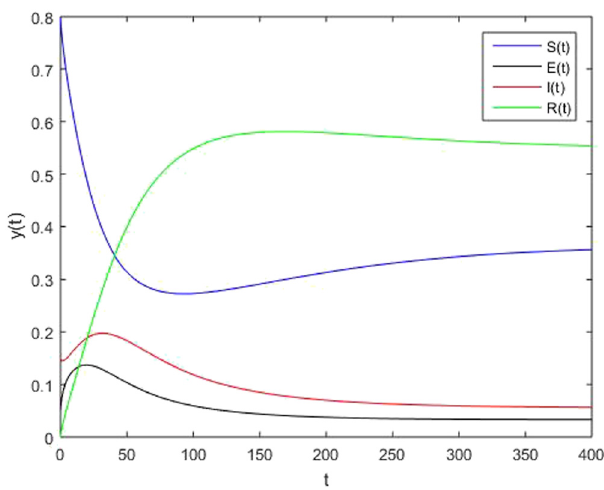
Figure 2: A solution to the SEIR model with fractional order α = 0.80.